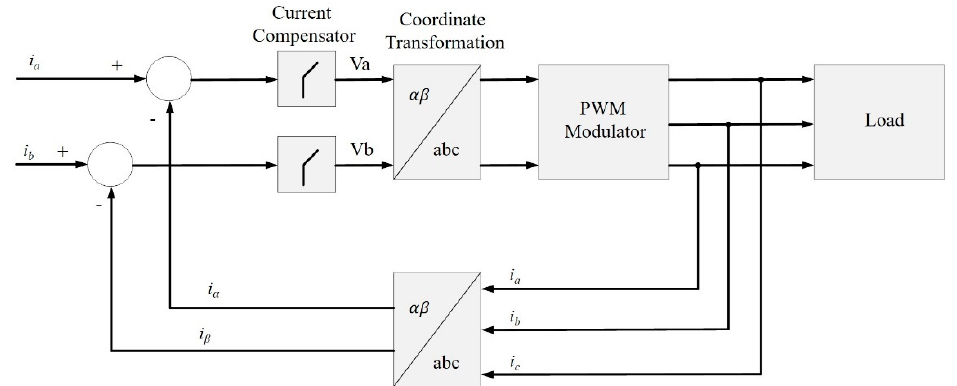
Figure 22. The schematic plot of stationary linear current regulator.